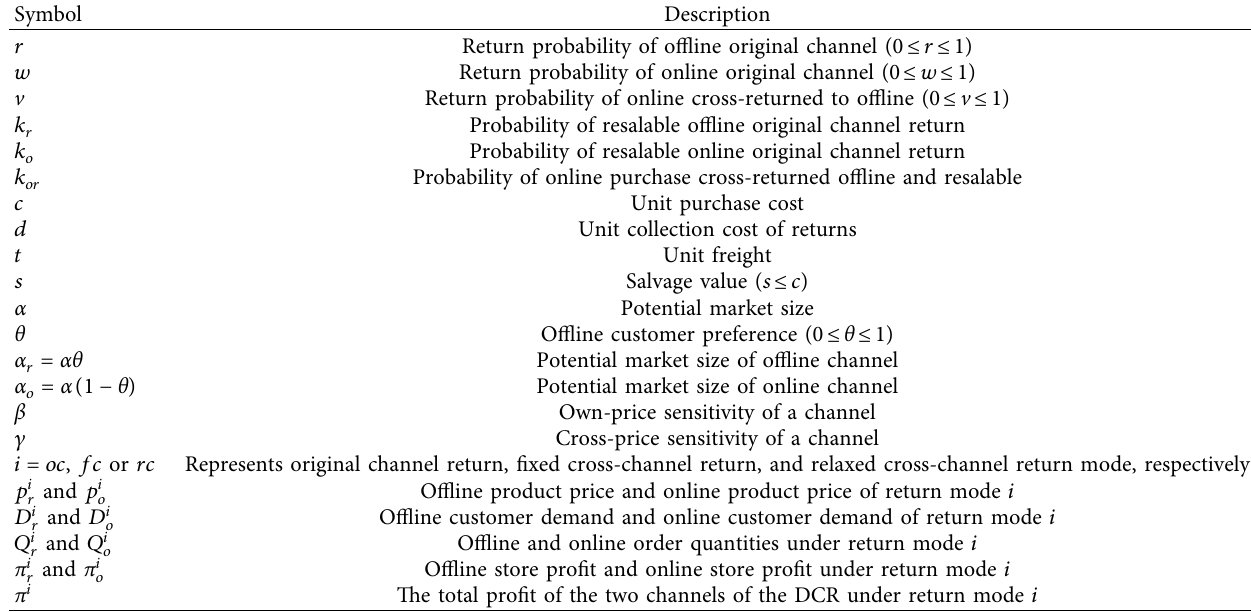
Table 1: Symbols and corresponding descriptions.